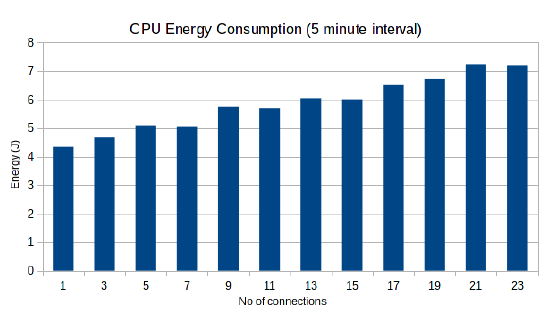
Figure 9. CPU Engergy Consumption on Mobile